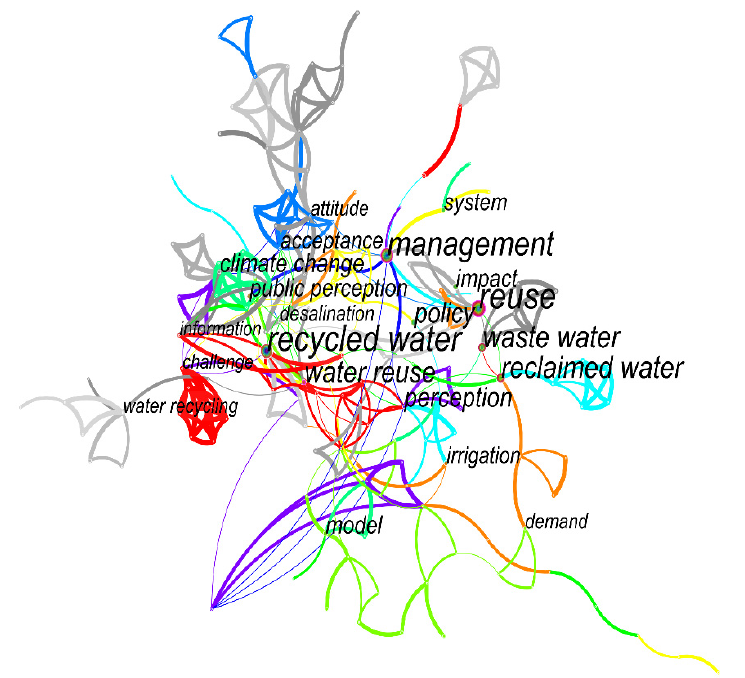
Figure 8. Cooccurrence of keywords in CNKI.